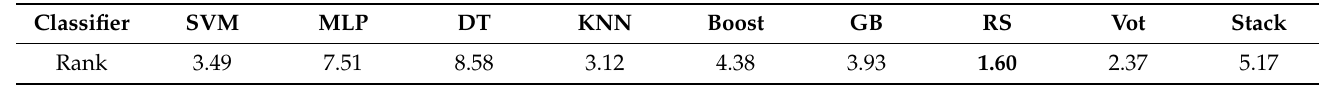
Table 6. Friedman Rank Test for Each